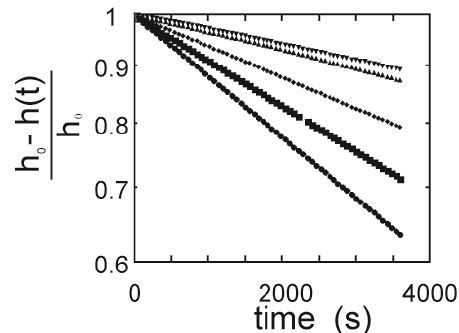
Figure 7. Semi-logarithmic plot of the relative height change. The mole fraction of the cross-linker is 0.5, 0.45, 0.4, 0.35 and 0.3, from top to bottom.